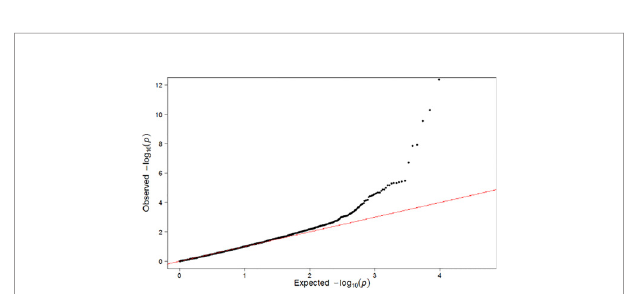
FIGURE 5 | Manhattan Plot for Genome-Wide Gene-Based Analysis Results.